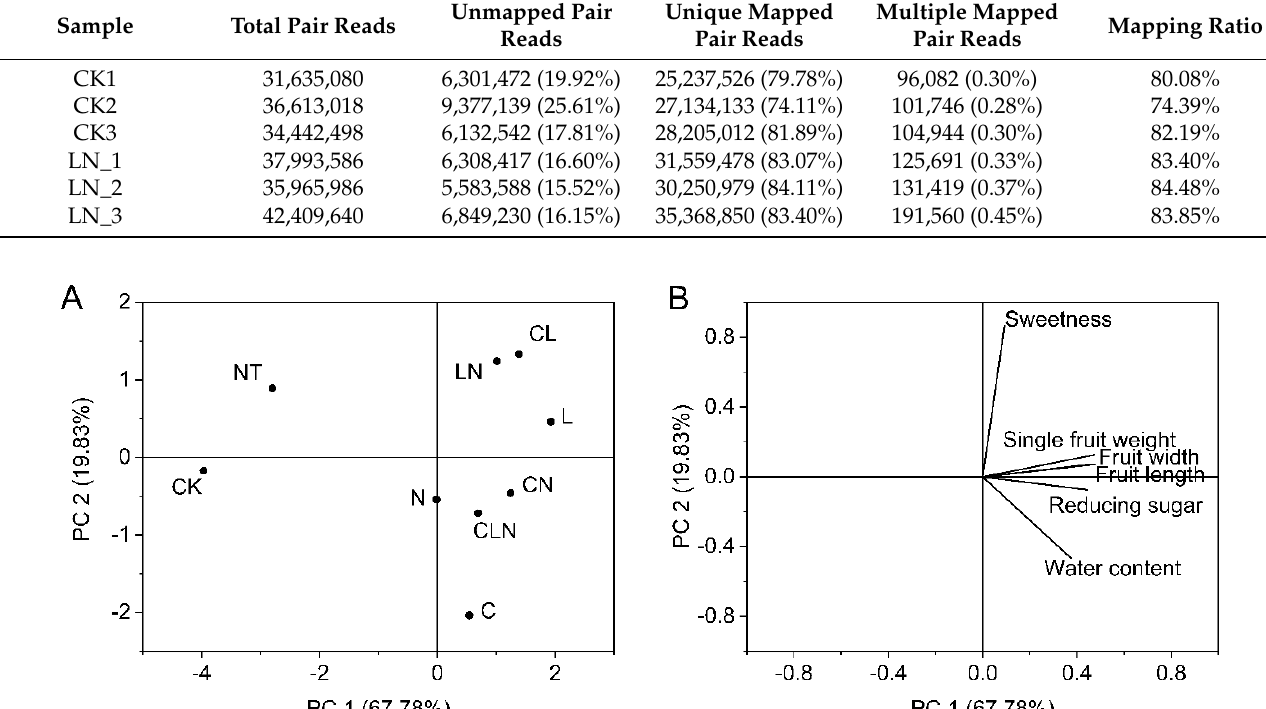
Figure 7. ( A , B ) Principal component analysis of fruit indices in the fruit stage of papaya. Whereas CK—the control without the use of bio-pesticides, C—use of 0.50 g L − 1 Chitosan, L—use